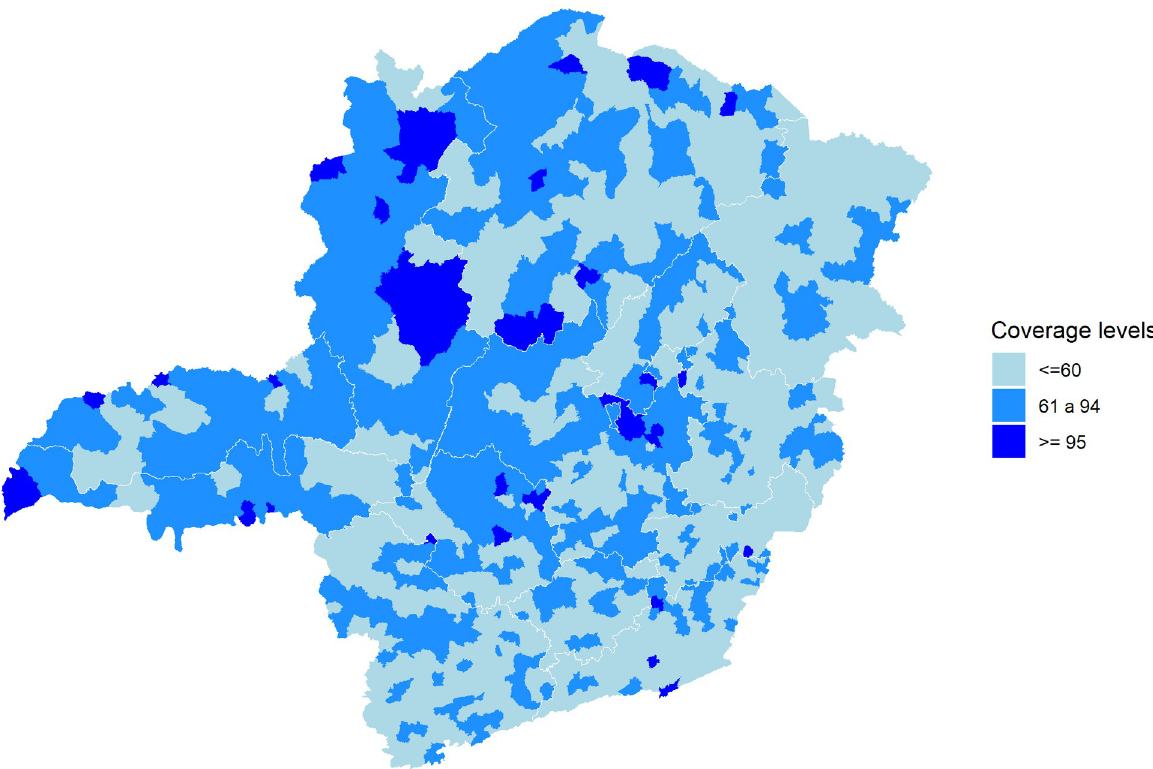
Fig 4. Yellow fever vaccination coverage (2016) in municipality general populations (adult and children). Data from Secretariat of Health of Minas Gerais, Brazil. Coverage categories refer to vaccination coverage in children under one year of age and classified in three categories, less than 60%, 61% to 94%, and 95% or greater. Map created with ggplot2 and sf packages (R platform)—base layer from Instituto Brasileiro de Geografia e Estatı´stica